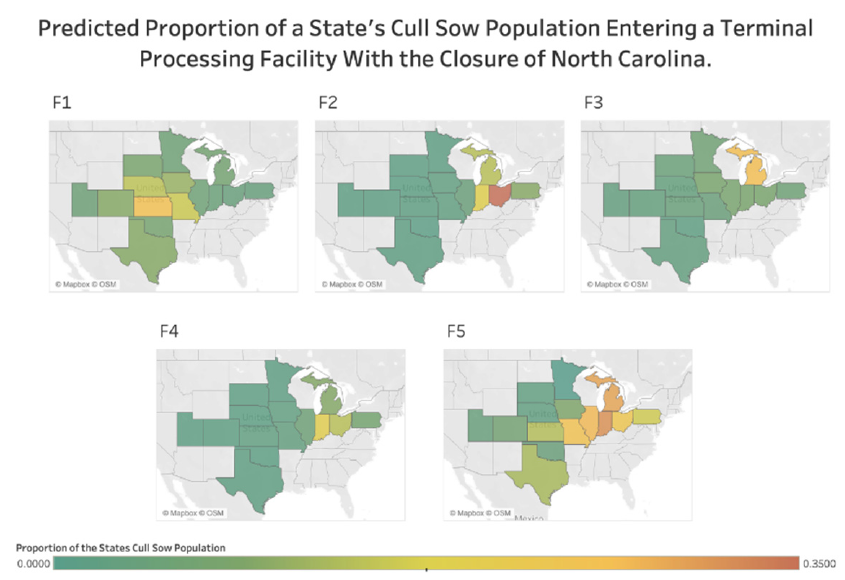
Figure 2. The predicted proportion of a state’s cull sow population that enters each terminal processing facility F1–F5, with a closure of movements to and from North Carolina. Each pane labeled F1, F2, F3, F4, F5 represents a different processing facility.